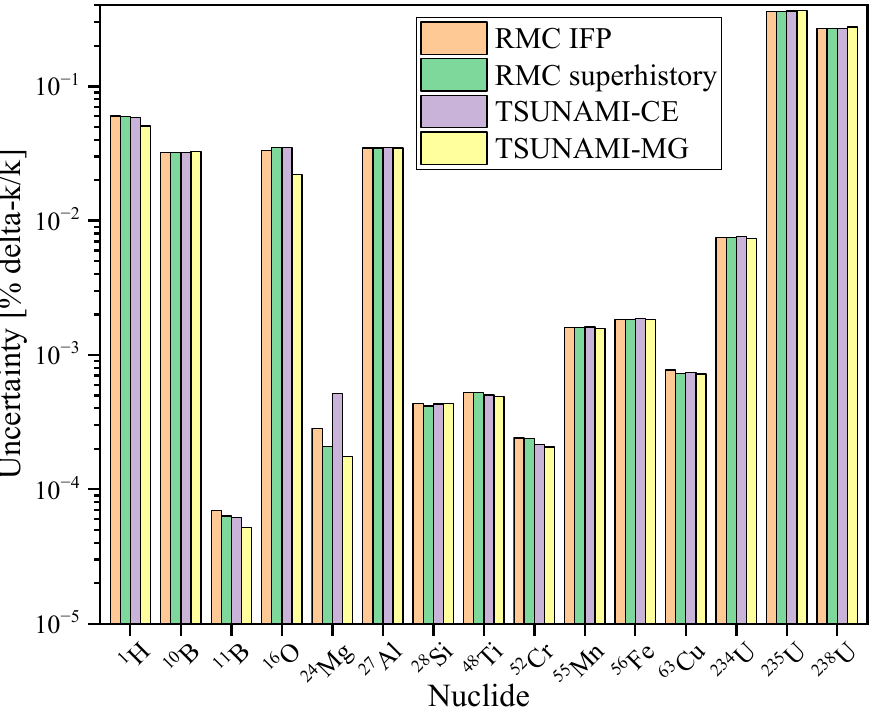
Figure 6. Uncertainty in k eff caused by uncertainty of nuclear data of different nuclides (SCALE 44-group covariance library). Table 9. Uncertainty of nuclides (SCALE 44-group covariance